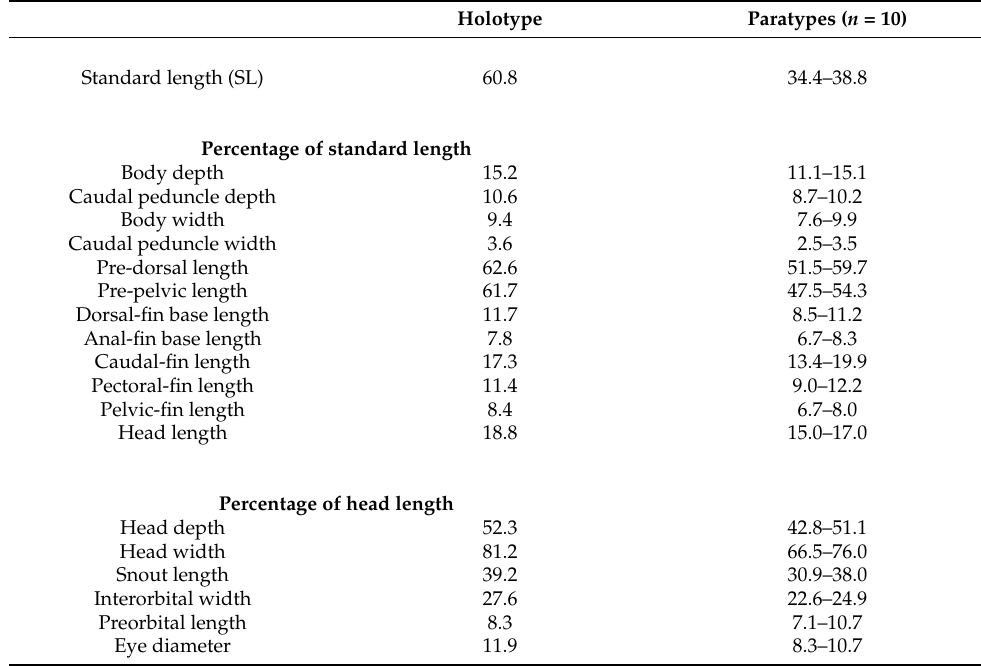
Table 6. Morphometric data of Trichomycterus coelhorum Costa, Azevedo-Santos & Katz sp.